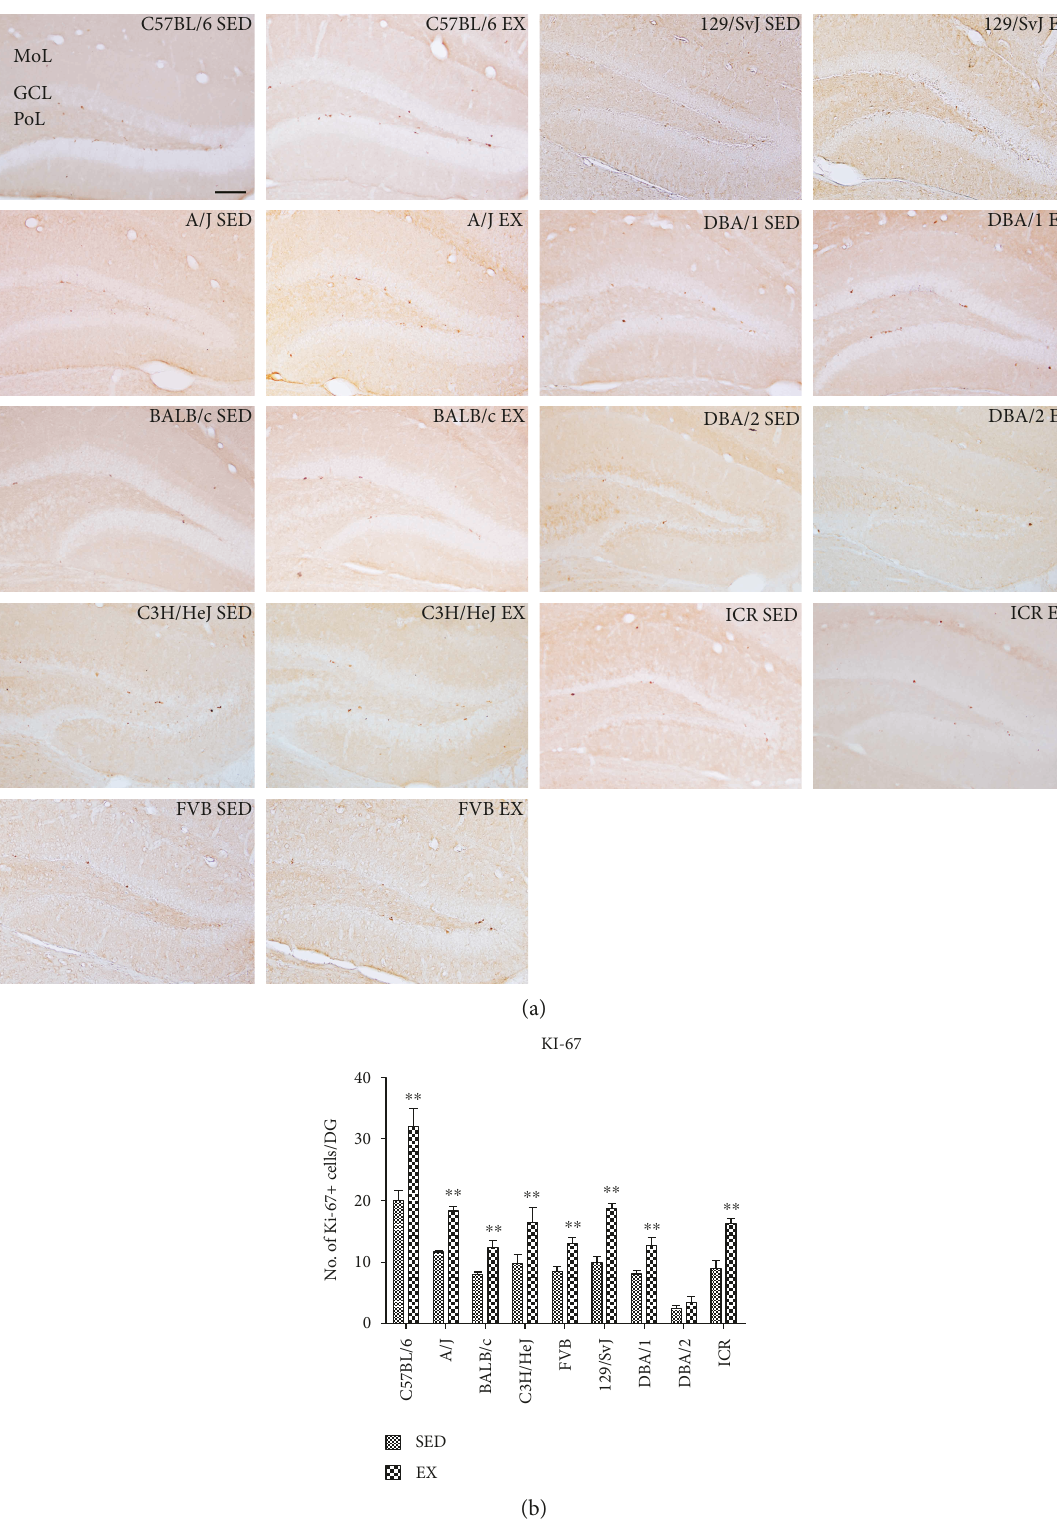
Figure 3: Immunohistochemistry for Ki67 in the dentate gyrus of sedentary and exercise mice of 9 di ff erent strains (a). GCL, granule cell layer; ML, molecular layer; PoL, polymorphic layer. Scale bar =100 μ m. Quantitative analysis of Ki67-positive nuclei per section in sedentary and exercise mice (b) ( n = 5 per group); ∗∗ indicates a signi fi cant di ff erence between the sedentary and exercise groups ( p < 0 01 ). Data are shown as mean ±